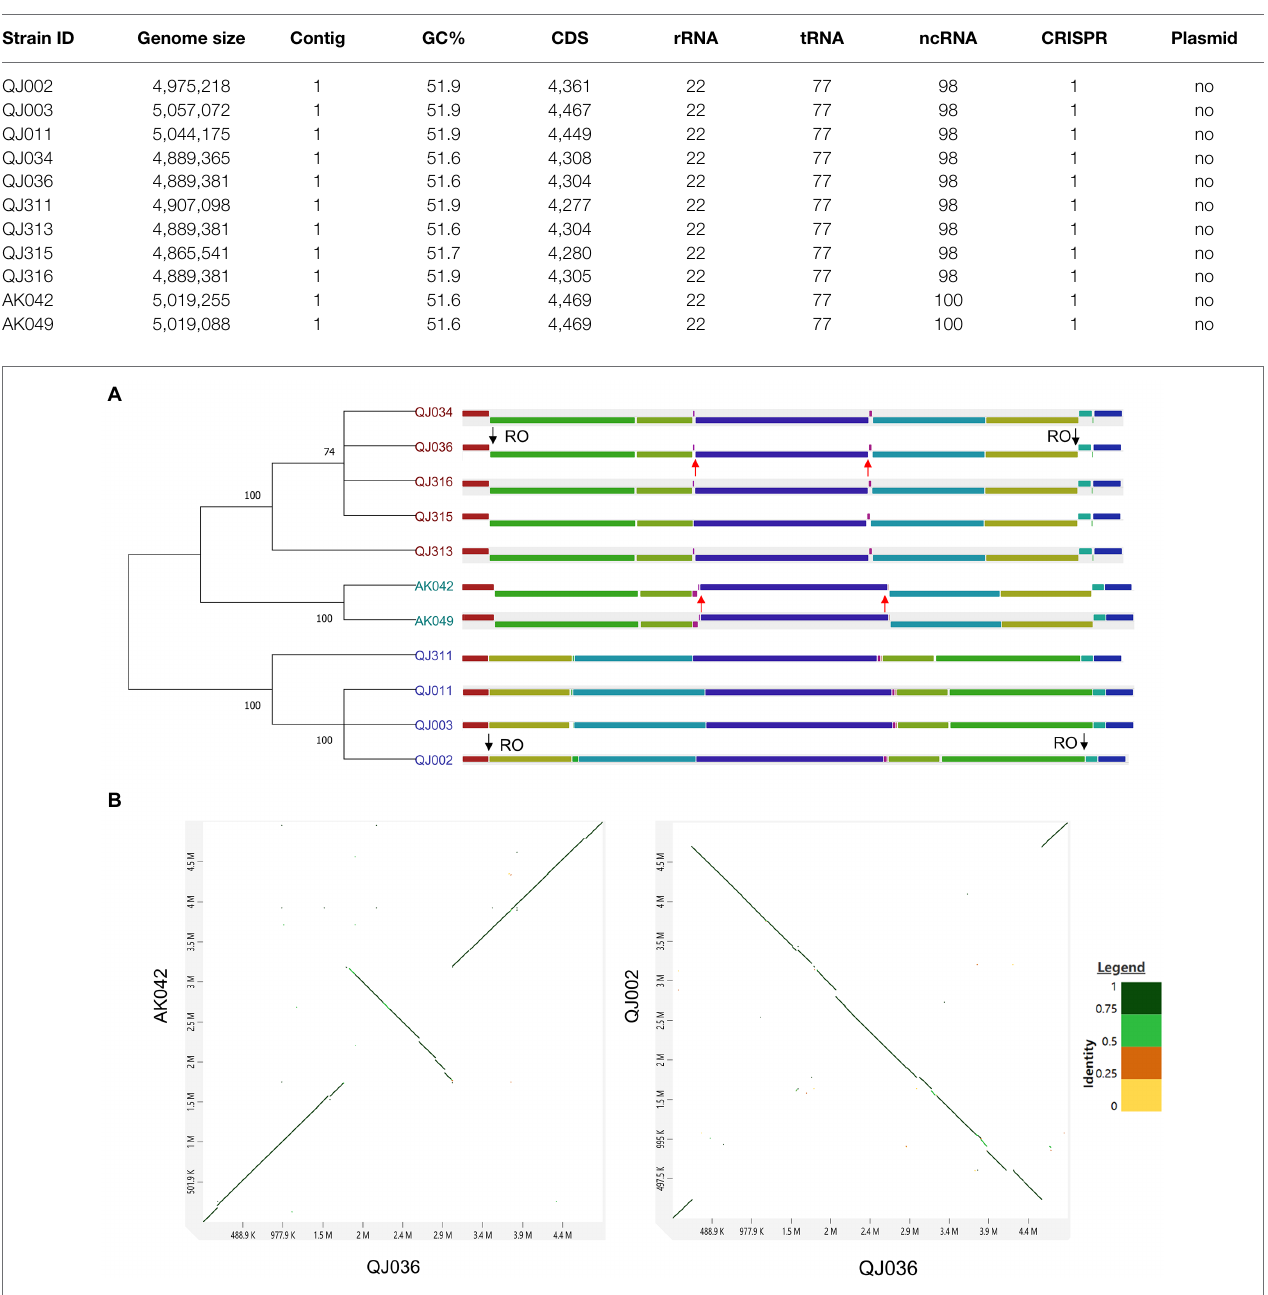
FIGURE 3 | Synteny analysis of Pectobacterium aroidearum strains. (A) Genome alignment using the progressiveMauve algorithm. Each locally collinear block (LCB) is assigned a unique color. The black arrows indicate the inversion region between QJ036 and QJ002 while the red arrows indicate the inversion region between QJ036 and AK042. RO stands for ribosome operon. SNPs-based parsimony tree of 11 Pectobacterium strains was constructed by kSNP3 and the condensed tree with a root at midpoint was computed by MEGA11 with the default cutoff value ( ≥ 50). (B) Pairwise genome alignment for the selected strains is shown in the dot plots generated by an online tool